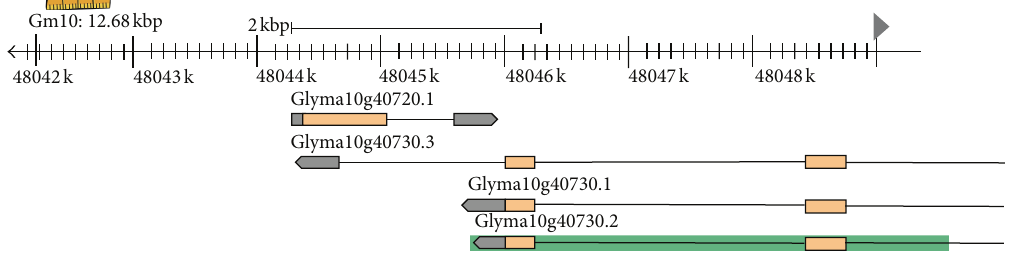
Figure4: cis -NATpairinvolvingGlyma10g40730andGlyma10g40720transcripts.AdaptedfromPhytozomewebsite(http://www.phytozome